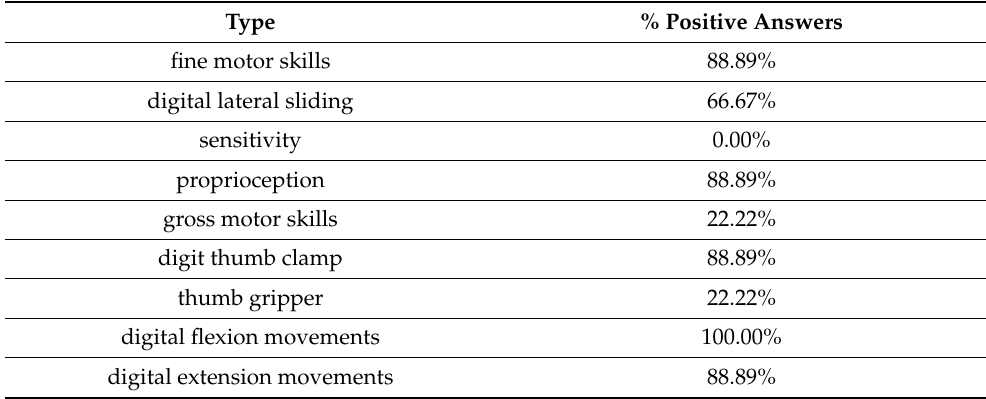
Table 2. Type of movements to be trained with the